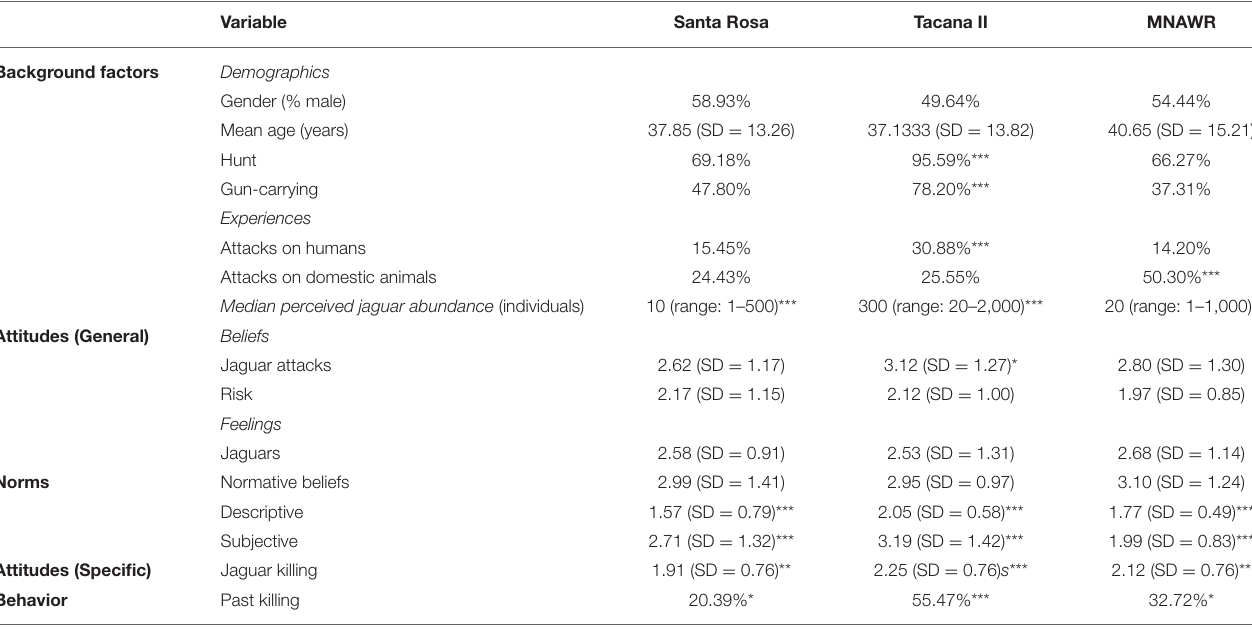
TABLE 1 | Descriptive statistics for background factors, attitudes, and norms in Santa Rosa del Abuná (Santa Rosa, n = 224), Tacana II ( n = 137), and Manuripi National Amazon Wildlife Reserve (MNAWR, n = 169); with significant results from ANOVA and ordinal linear regressions indicated.